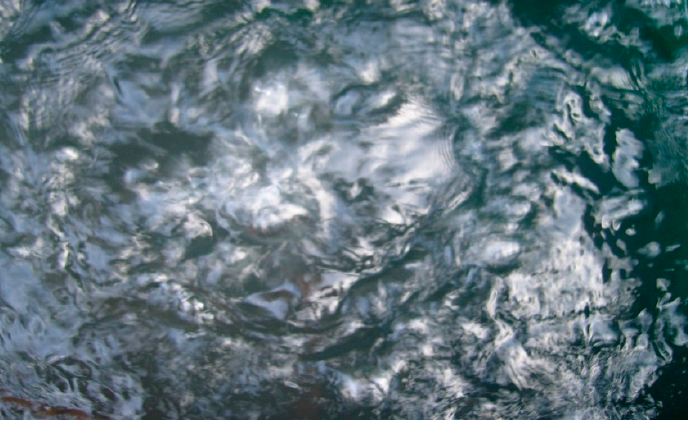
Figure 14. Reactor in operation. View of the air–water contact, showing a turbulent environment. Field of view = 25 cm.